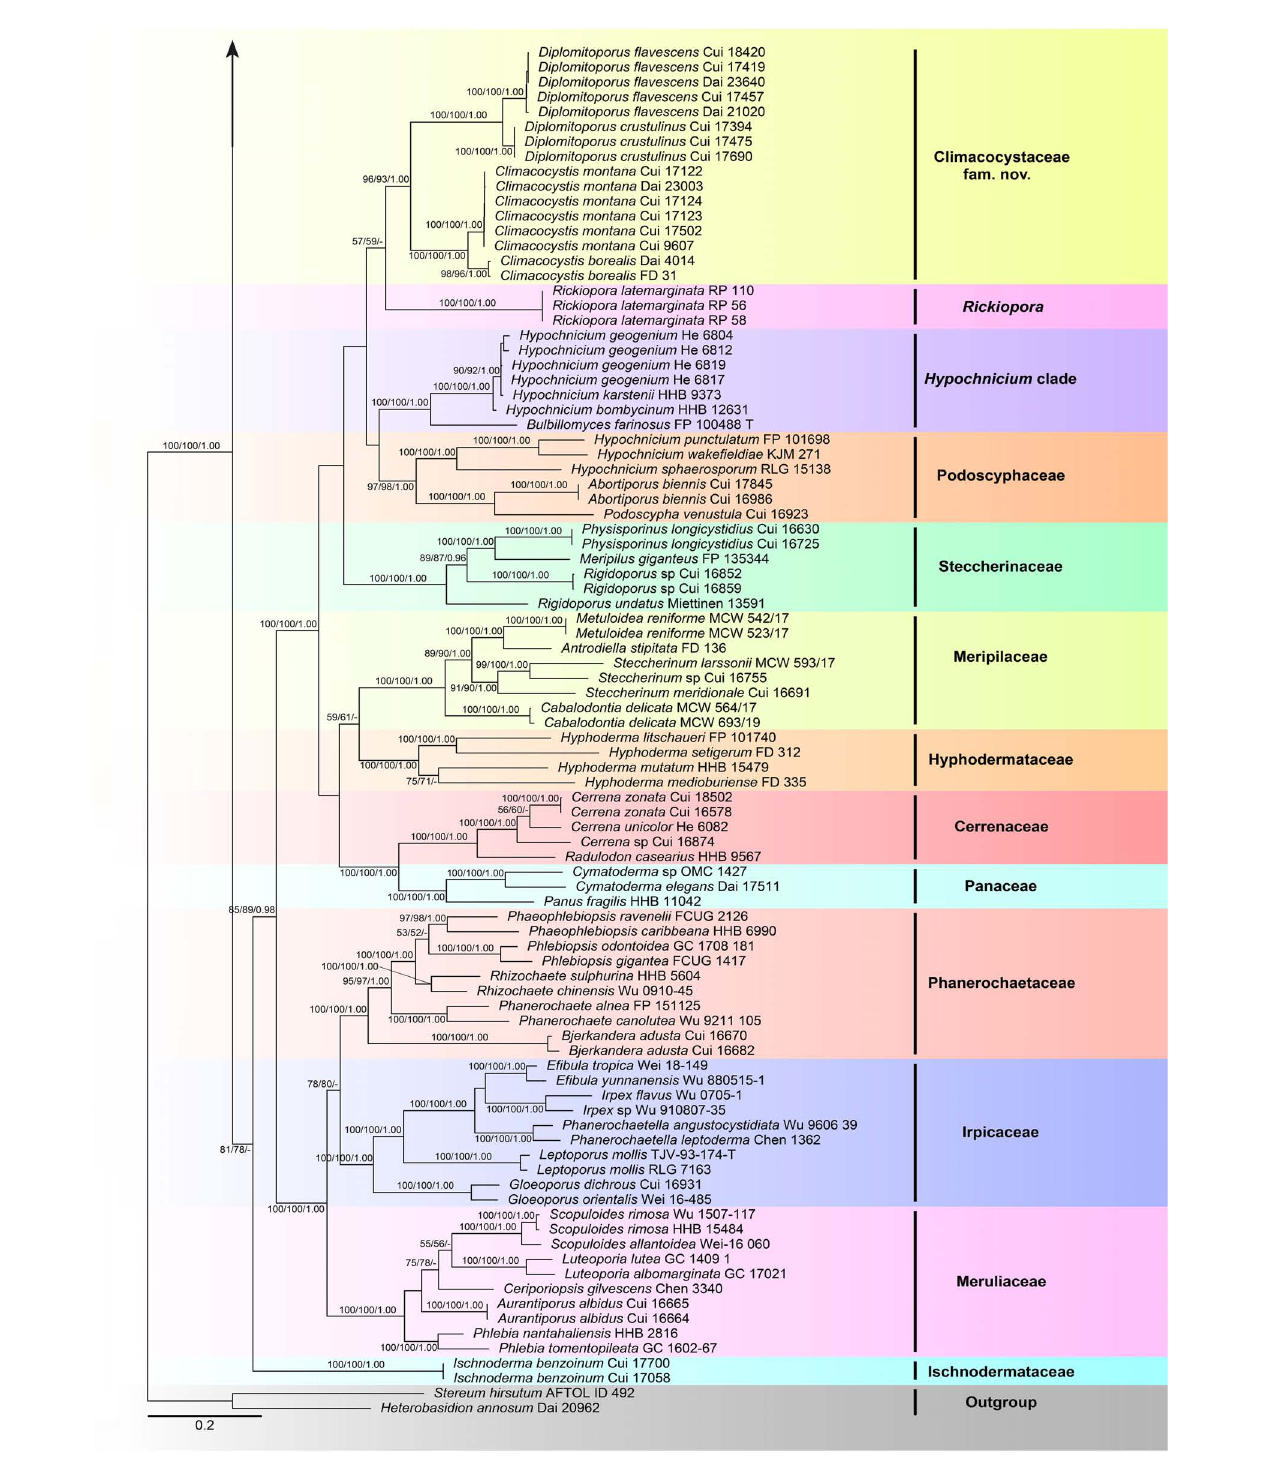
FIGURE1 Maximum likelihood tree illustrating the phylogeny of the Polyporales based on the combined sequence dataset of ITS + nLSU + RPB1. Branches are labeled with parsimony bootstrap proportions higher than 50%, maximum likelihood bootstrap higher than 50% and Bayesian posterior probabilities more than 0.90,